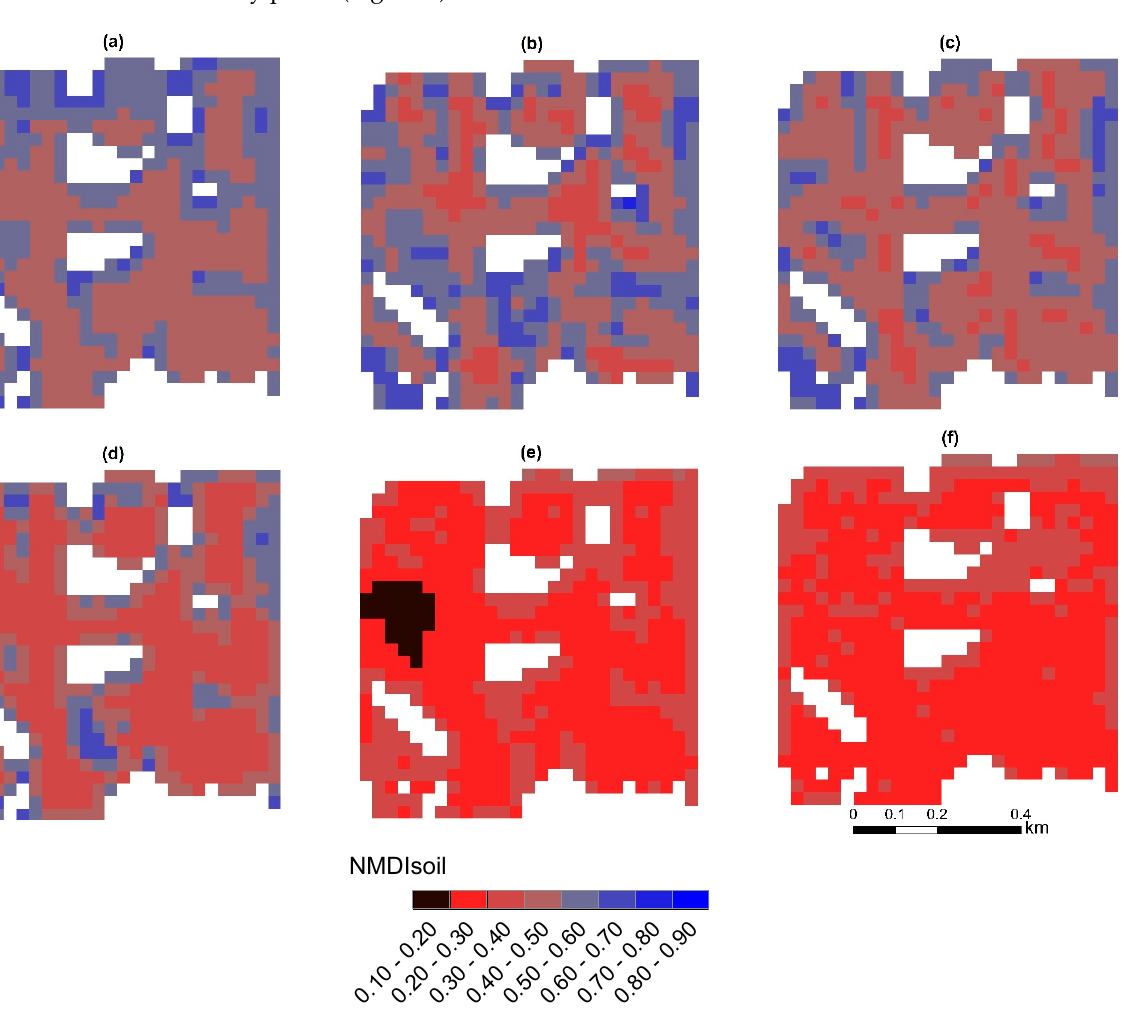
Figure 9. NMDISoil maps for the month of July for 2016 ( a ), 2017 ( b ), 2018 ( c ), 2019 ( d ), 2020 ( e ), and 2021 ( f ).